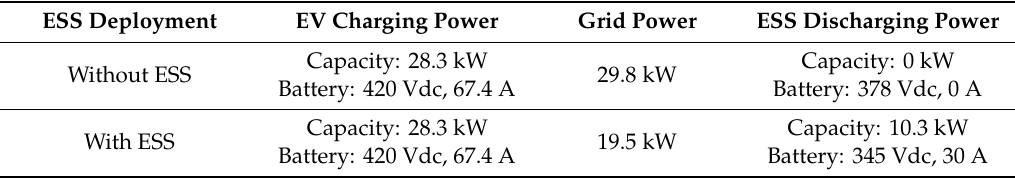
Table 3. Test results for peak demand cut using electric vehicles (EVs) and energy storage systems (ESSs).